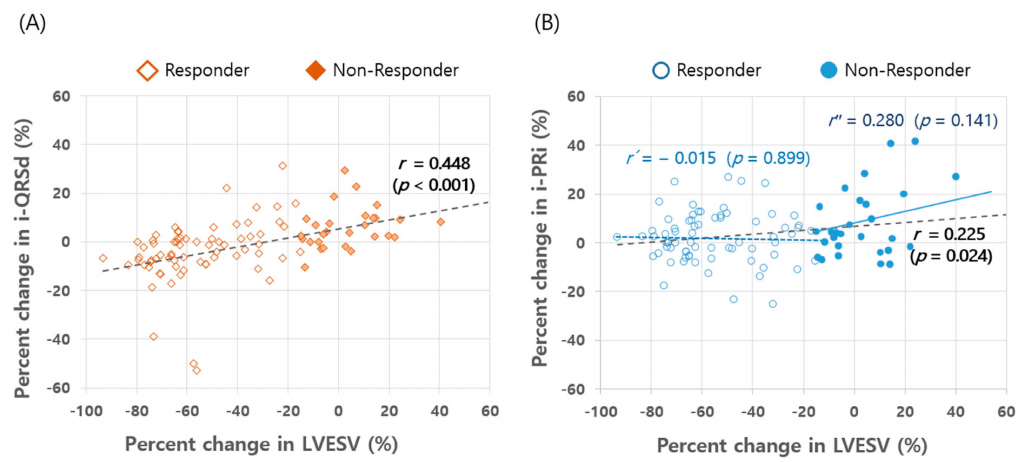
Figure 3. Correlation between relative changes in LV volumes and intrinsic QRSd ( A ) and PR interval ( B ). Responders and non-responders to CRT were divided by − 15% in relative change in LVESV. LVESV, left ventricular end systolic volume; i-PRi, intrinsic PR interval; i-QRSd, intrinisic QRS